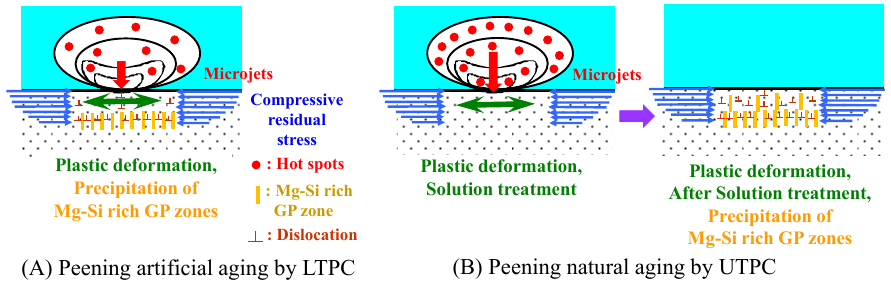
Figure 2. Schematic diagram of peening artificial aging by LTPC and peening natural aging by